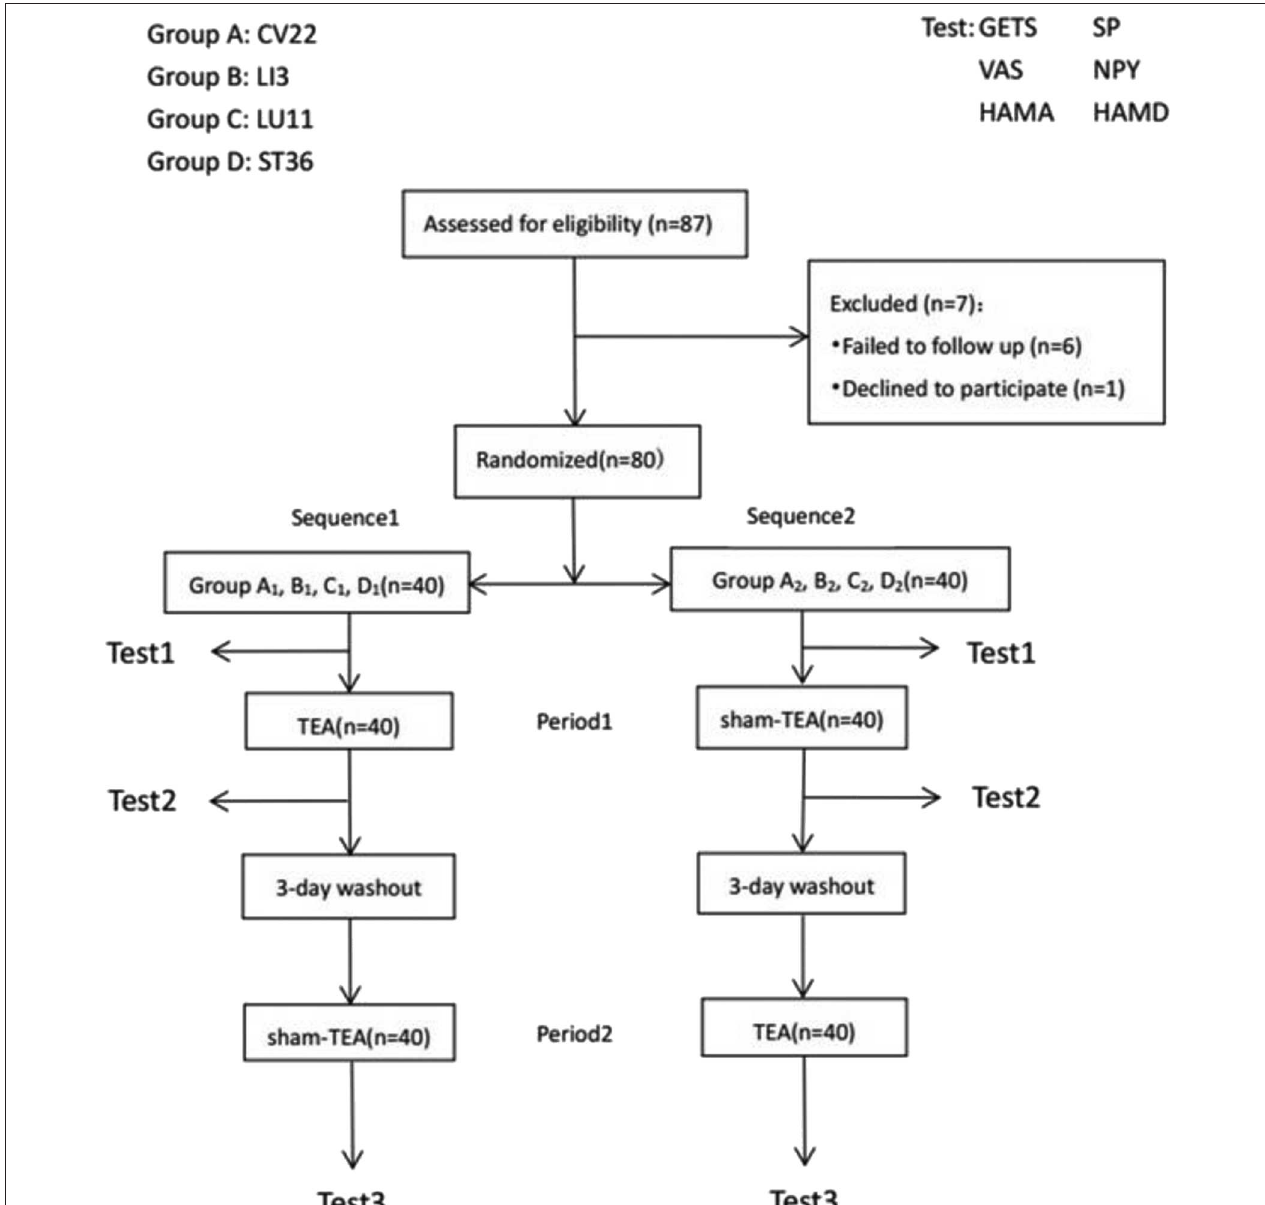
FIGURE 2 | Flow-process diagram. Study design: each large group contained 20 patients that were equally and randomly divided into two smaller group. Treatment, sequences, and periods for each smaller group with a minimum 3-day washout period was set between administration period to minimize any TEA or sham-TEA carry-over effect. Because test 1 was the first test before any treatment, its results were also considered as the baseline of each sequence.